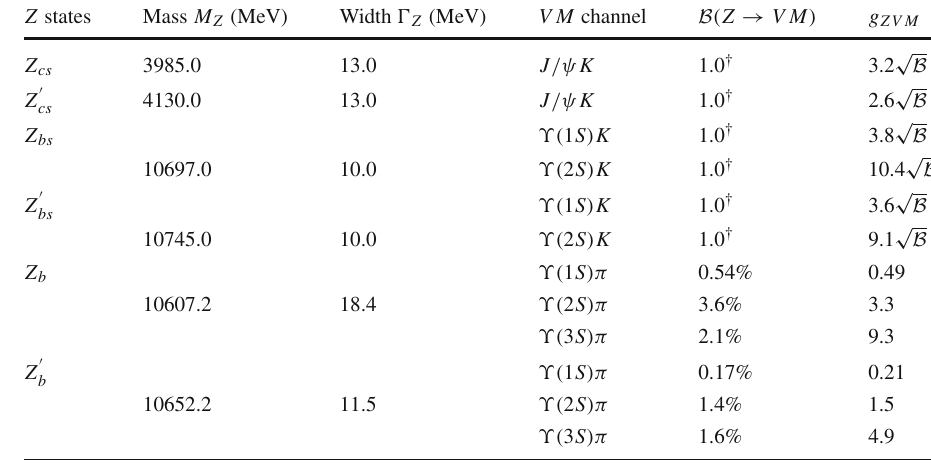
(cid:3) ) cs , ( (cid:3) ) are bs